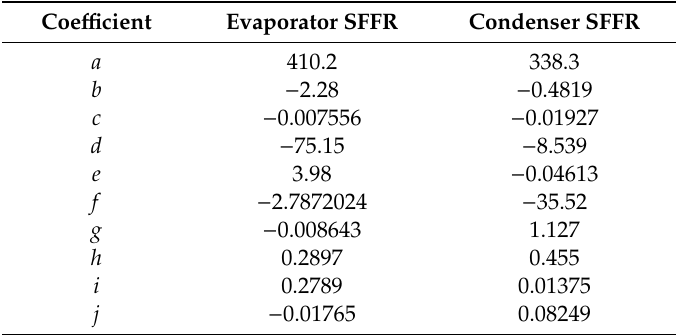
Table 5. Coe ffi cients of the MSSFF